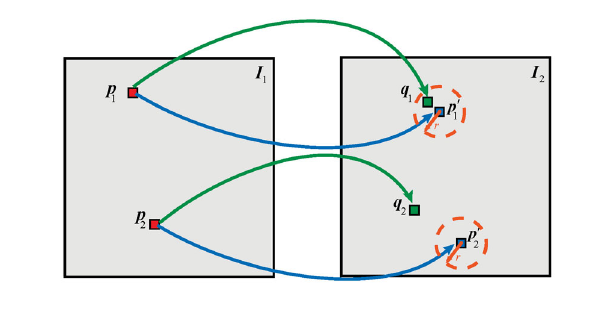
Fig. 3 Inlier / outlier pixel discrimination. p 1 represents an inlier while p 2 represents an